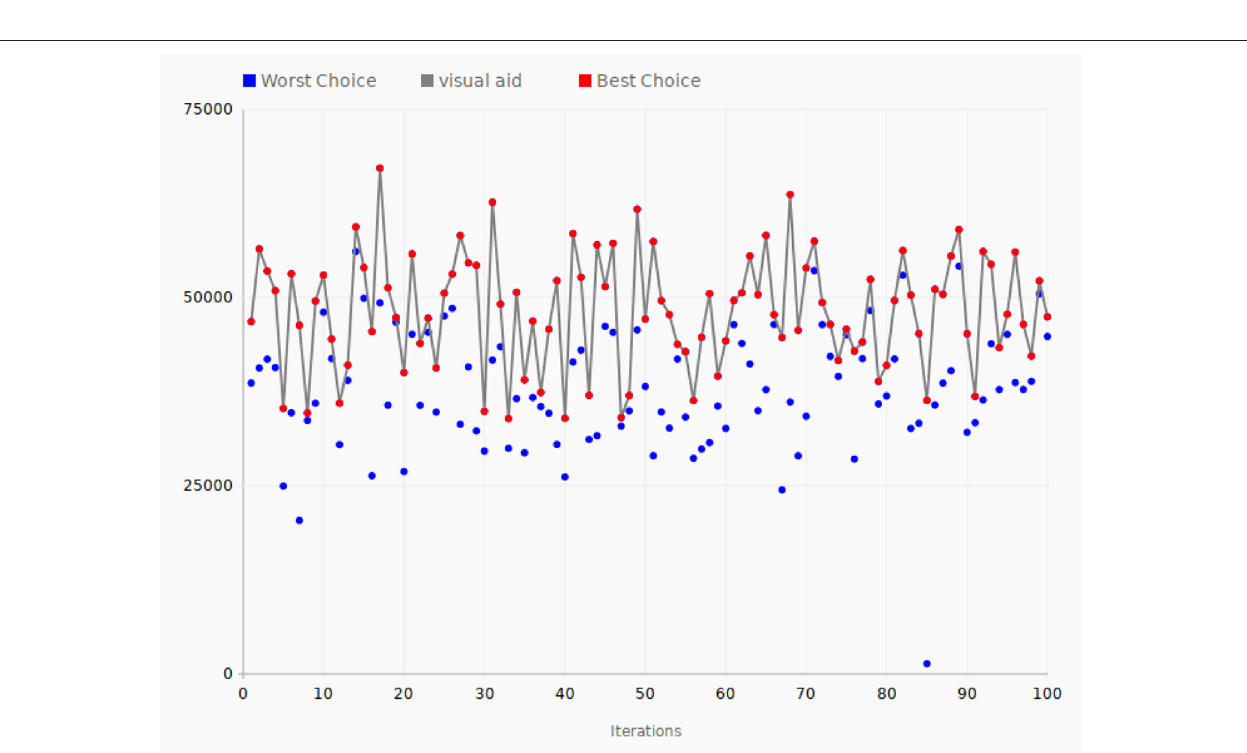
FIGURE 7 | Tuning iterations—GeoNames. The gray line connects the best choices that give the largest value of the objective function for each of the 100 iterations.